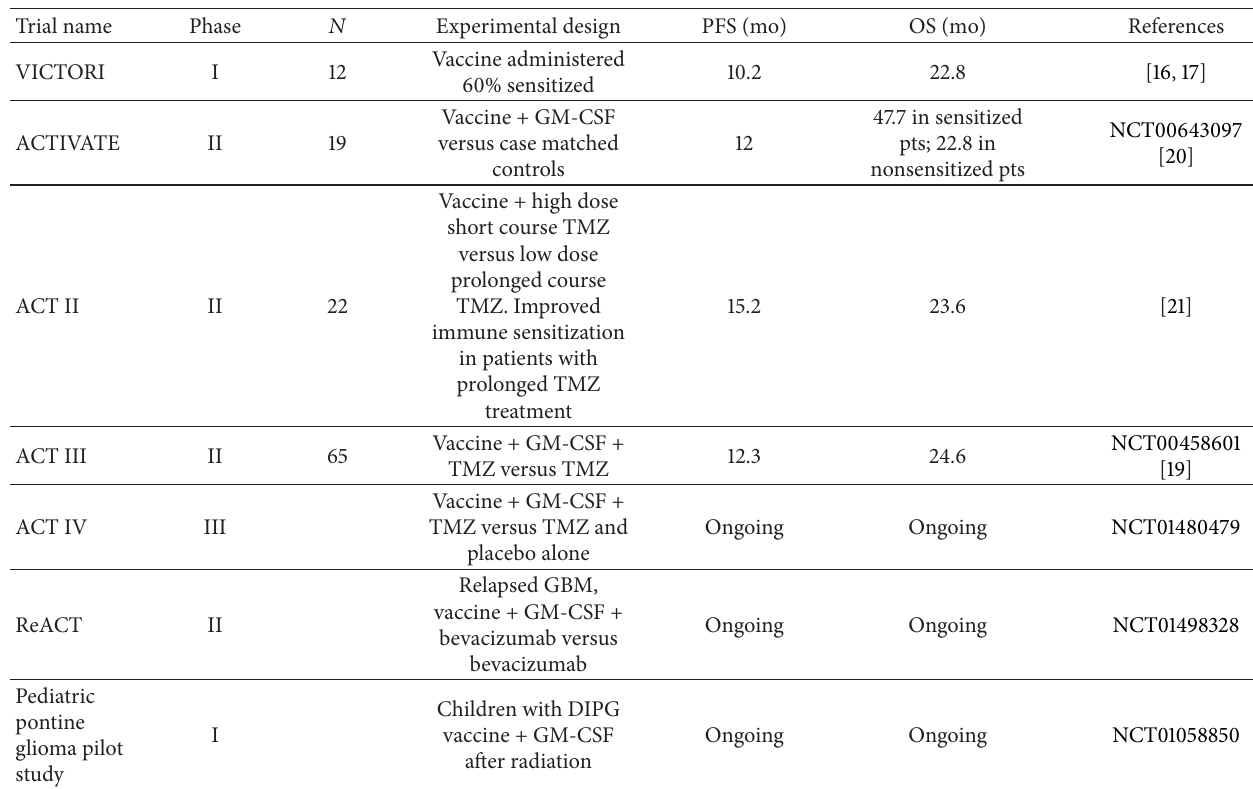
Table 2: EGFRvIII vaccine